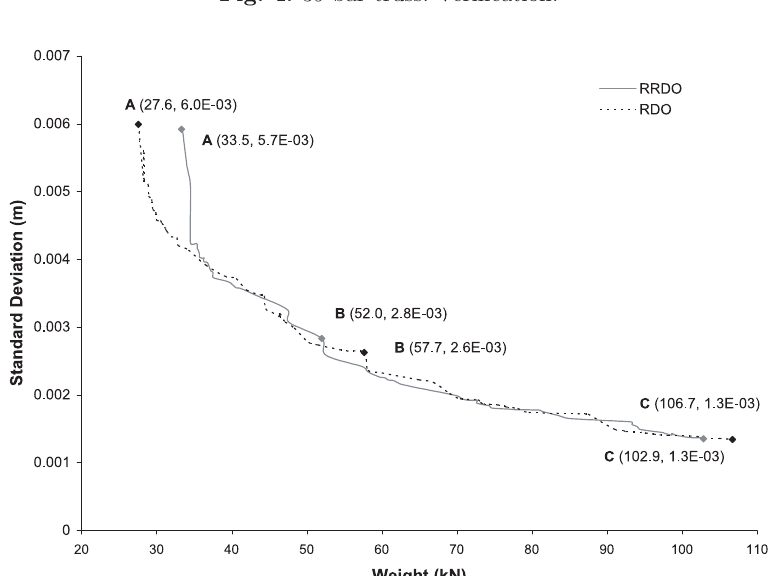
Fig. 4. 39-bar truss: Verification.